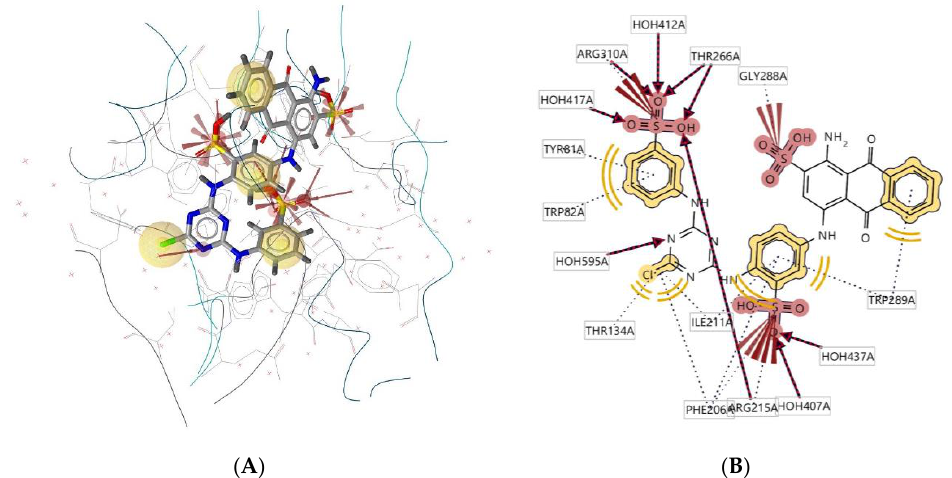
Figure 12. Ligand 950D interacts with the macromolecule. ( A ) 3D view of pharmacophore at the macromolecule binding site. ( B ) 2D view of pharmacophore. Pharmacophore features: hydrophobic interactions (H), yellow; hydrogen bond acceptor (HBA), red; negative ionisable area (NI) interaction, brick red.